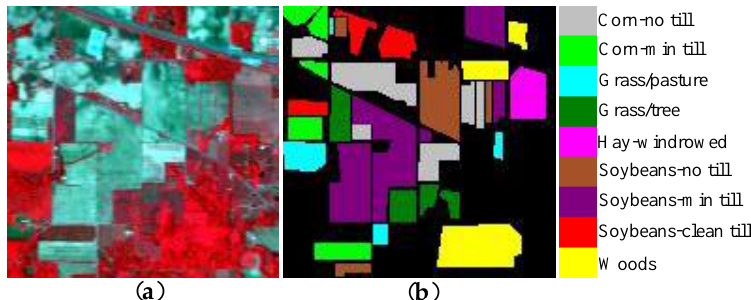
Figure 5. Indian Pines dataset. ( a ) Three-band false-color image. ( b ) Ground truth-map containing nine land-cover